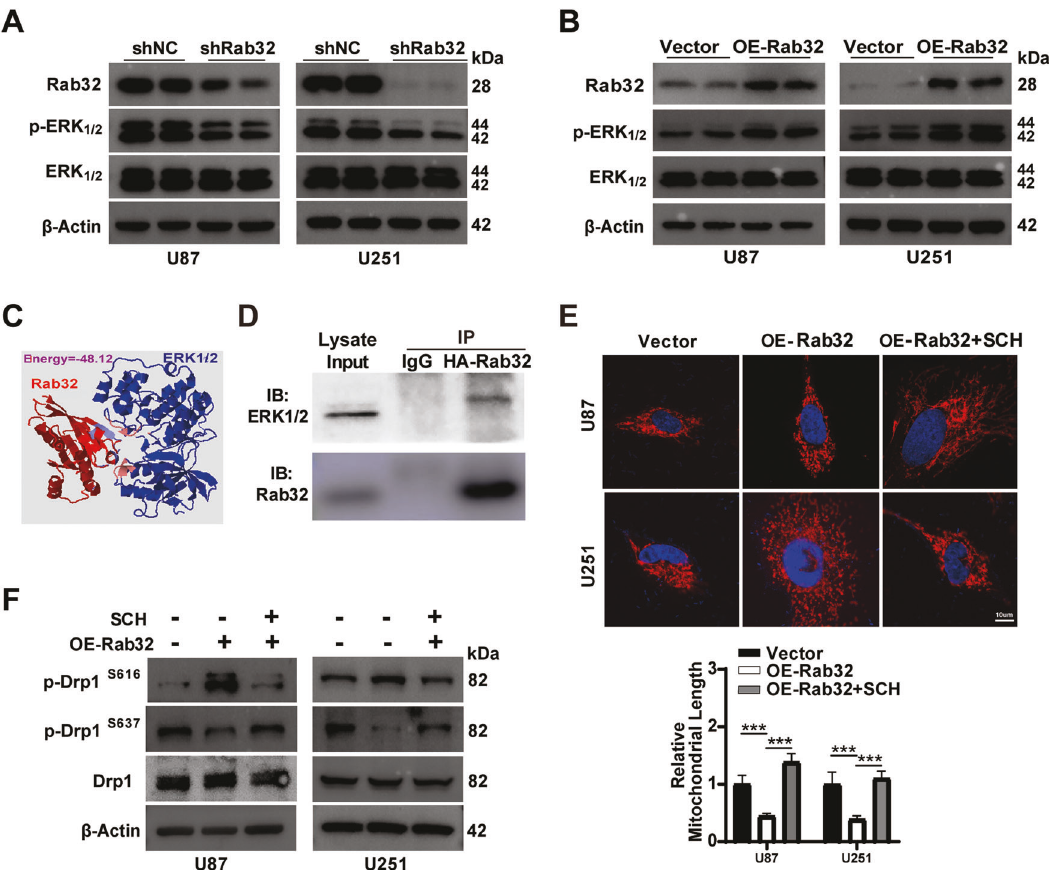
Fig. 6 Rab32 recruited ERK for Drp1 activation. A , B Western blot analyzed the level of p-ERK 1/2 in Rab32-silencing or overexpression U87 and U251 cells. β -Actin was used as a loading control. C Bioinformatics prediction of interaction between rab32 and ERK 1/2 based on structure- based protein interaction interface. D Immunoprecipitation assay evaluated the Rab32 interaction with ERK 1/2 in U87 cells. Rabbit IgG was used as a control. E Representative images and quanti fi cation of mitochondrial morphology assessed by Tom20 staining in OE-Rab32 U87 and U251 cells with or without ERK inhibitor SCH772984 (SCH, 1 μ M) treatment for 24 h. F Western blot detected the levels of pDrp1 (Ser616 and Ser637) in OE-Rab32 U87 and U251 cells with or without SCH772984 treatment (SCH, 1 μ M for 24 h). β -Actin was used as a control. The data are shown as the mean ± SD of three replicates. *** P < 0.001 vs. indicated